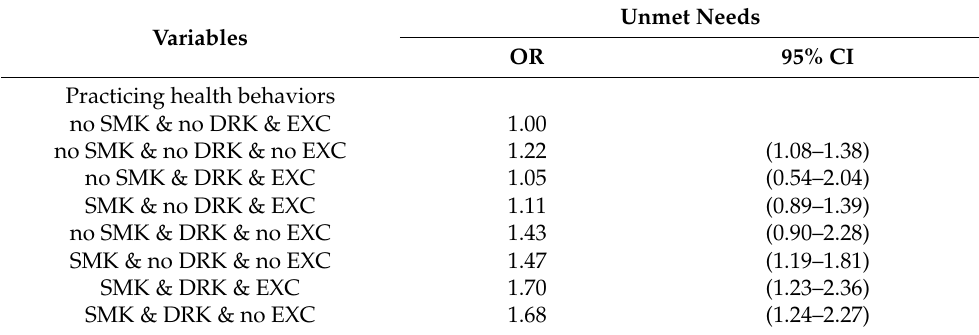
Table 3. Results of GEE analyzing the effect of type of practicing health behaviors on unmet needs *.